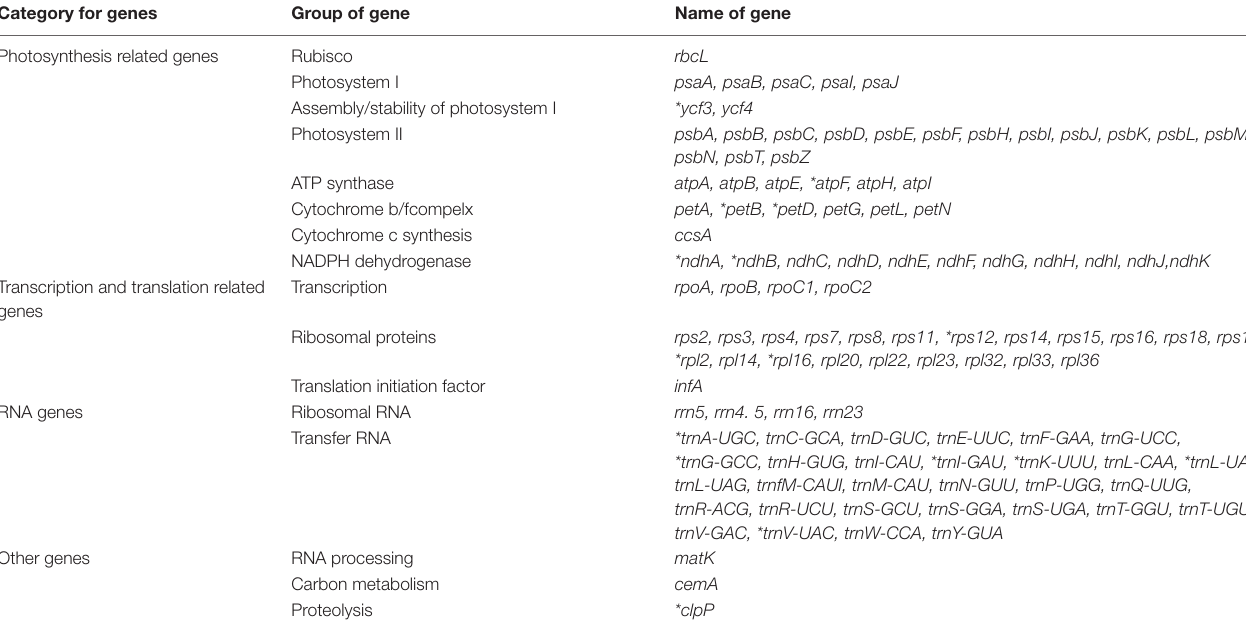
TABLE 2 | List of annotated genes in the chloroplast genome of P. glaucum. Category for